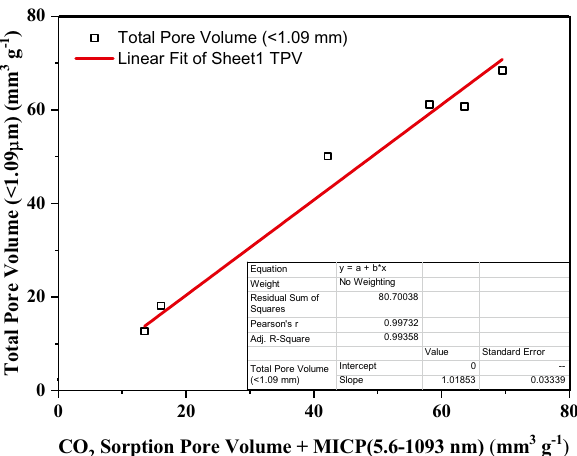
Fig. 11 The variation of Dubinin–Radushkevich micropore volume, CO sorption pore volume (< ~5.6 nm) and Hg total pore volume 2 from MICP porosimetry at 1093 nm with vitrinite reflectance for Posidonia shales (data from Ref. [34])